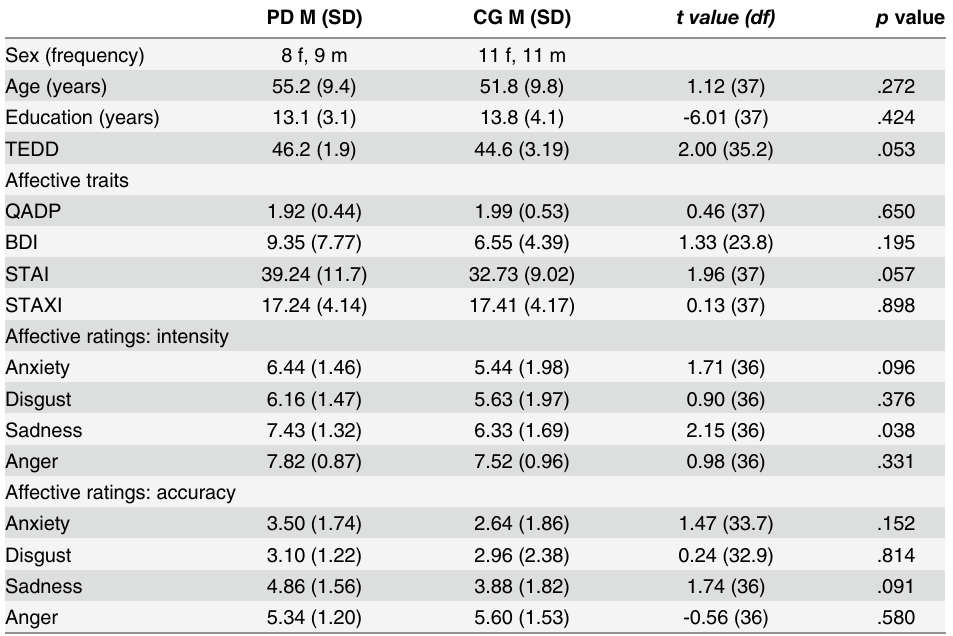
Table 1. Overview of descriptive data for patients with Parkinson ’ s disease (PD) and the control group (CG). PD M (SD) CG M